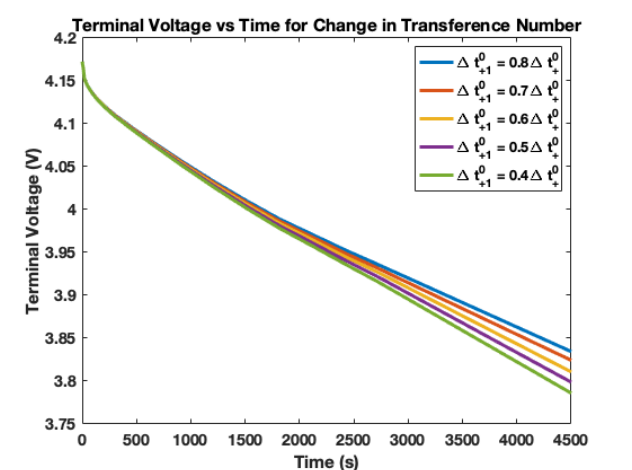
Figure 11. Terminal voltage vs. time for change in transference number from 0.8 to 0.4.